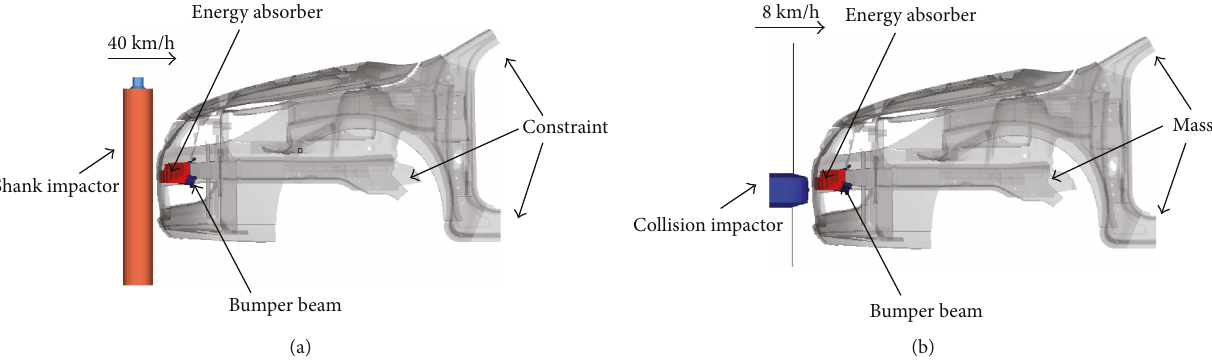
Figure 4: Finite element models of (a) pedestrian lower extremity impact and (b) low-speed